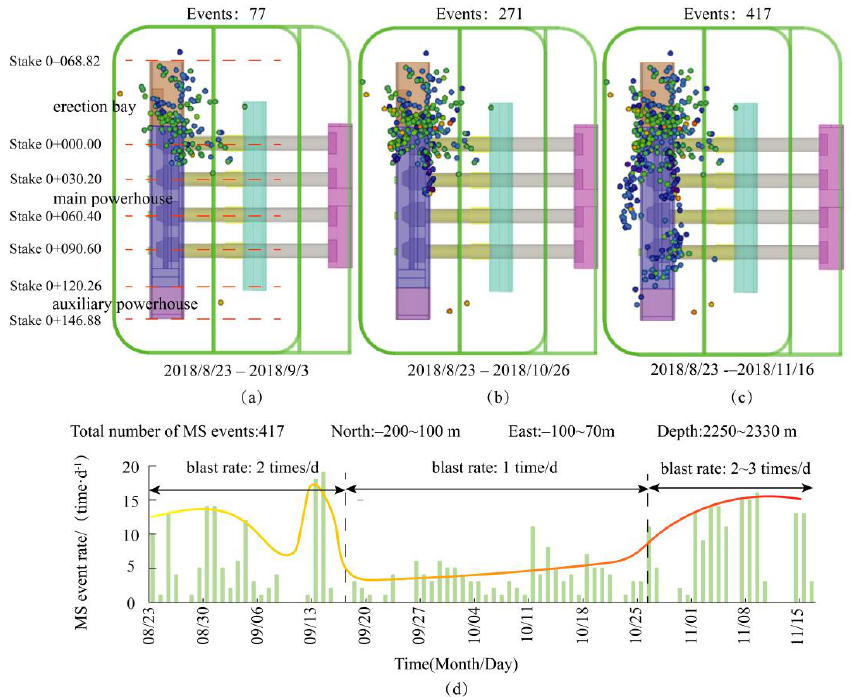
Figure 8. Spatial and temporal evolutions of the MS events from 23 August to 16 November 2018. ( a ), Spatial and temporal evolutions of the MS events from 23 August to 3 September 2018; ( b ), Spatial and temporal evolutions of the MS events from 23 August to 3 October 2018; ( c ), Spatial and temporal evolutions of the MS events from 23 August to 16 November 2018; ( d ), The activity rate of the daily MS events.